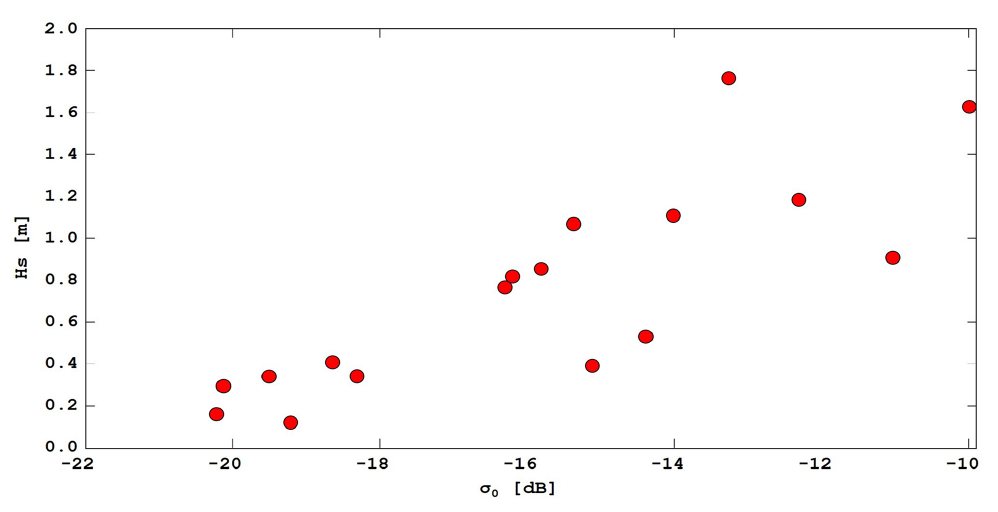
Figure 3. Scatter plot showing the correlation between the mean backscattering coefficient (computed offshore) and the significant wave height measured by a wave buoy (Test Site